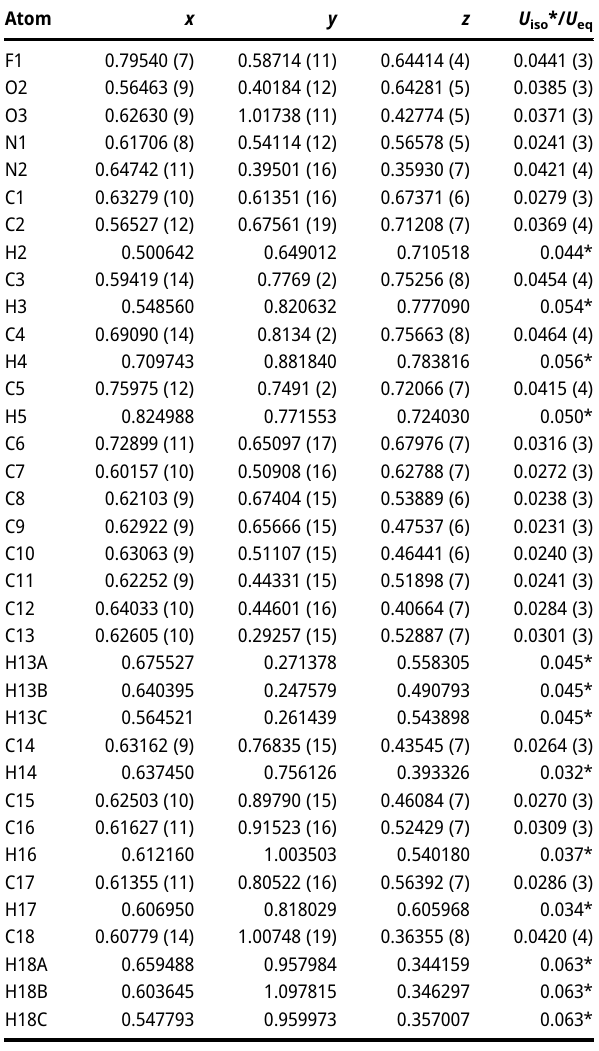
Table  : Fractional atomic coordinates and isotropic or equivalent isotropic displacement parameters (Å 